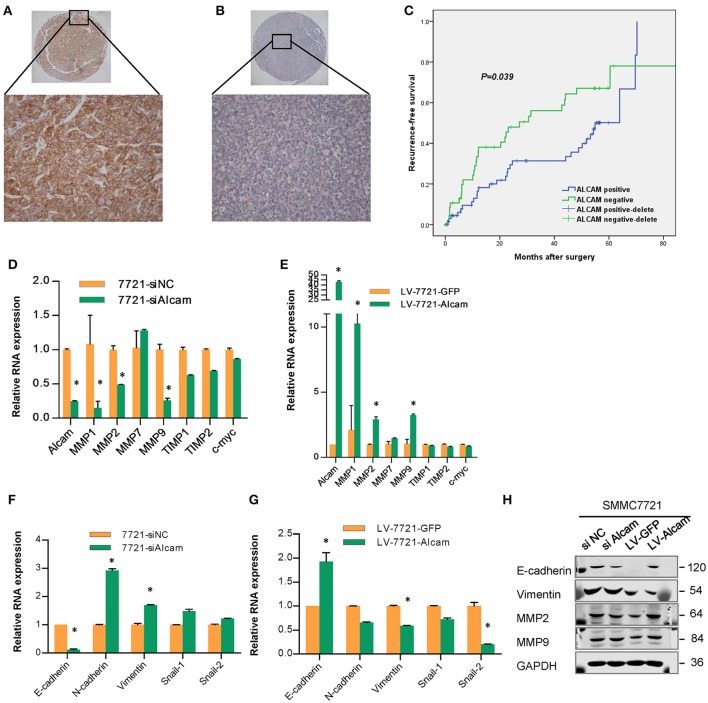
Immunohistochemistry staining and microarray analysis of ALCAM in HCC patients and relationship of ALCAM and EMT related genes. (A) The positive staining of ALCAM was mainly located at the cellular membrane, compared with negative staining in HCC (B); (C) Kaplan-Meier analysis of the correlation between ALCAM expression and the recurrence-free of patients with HCC. Log-rank tests were used to determine statistical significance. The expression of ALCAM was associated with the recurrence-free survival of patients with HCC, ALCAM negative cases had worse TTR than positive cases (log-rank test, p < 0.05). (D–G) Relative mRNA levels as measured by qPCR of the EMT related genes in SMMC-7721 cells transfected with si-NC or si-ALCAM (D,F) and infected with control and LV-ALCAM (E,G). (H) Western blot showed that the expression of ALCAM and the EMT markers in SMMC-7721 cells with ALCAM siRNAs or stably transfected with Lenti-ALCAM. *p < 0.05.